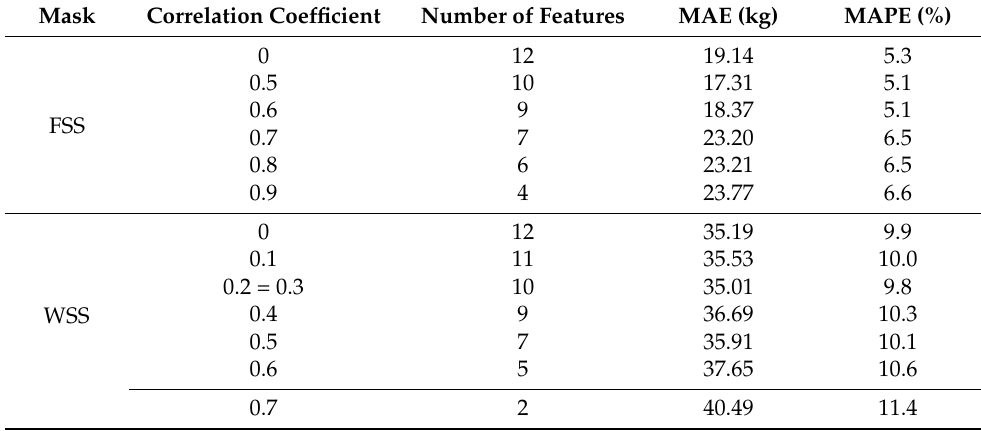
Table 5. Performance of the proposed method according to correlation coefficient intervals. Mask Correlation Coefficient